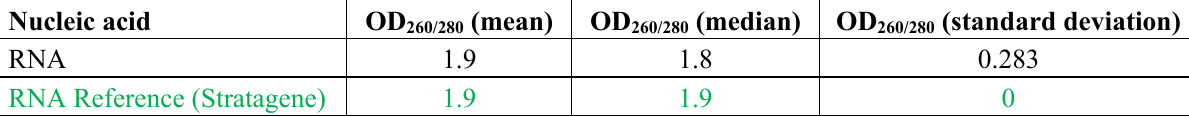
Table 4. Optical density (OD Reference (Stratagene).